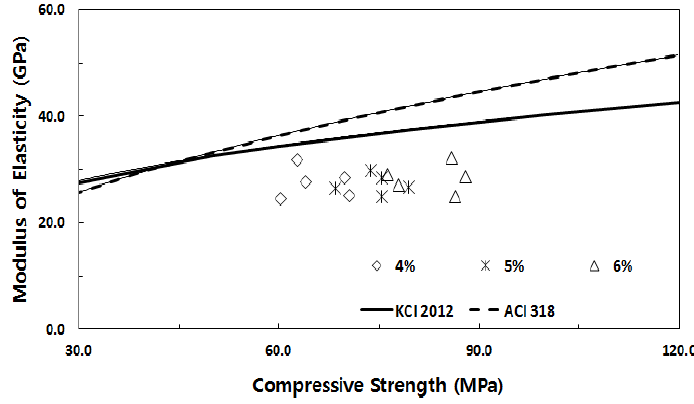
Figure 6. Correlations of compressive stress and elastic modulus between KCI 2012 [30] and ACI 318 [31].